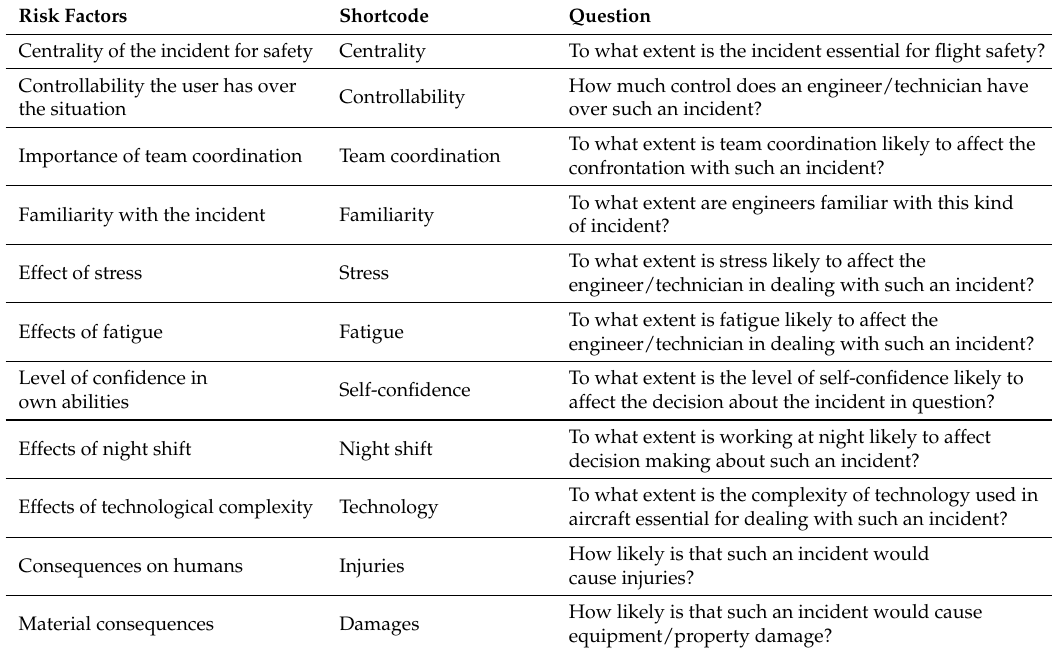
Table 1. Questions Corresponding to the Eleven Risk Perception